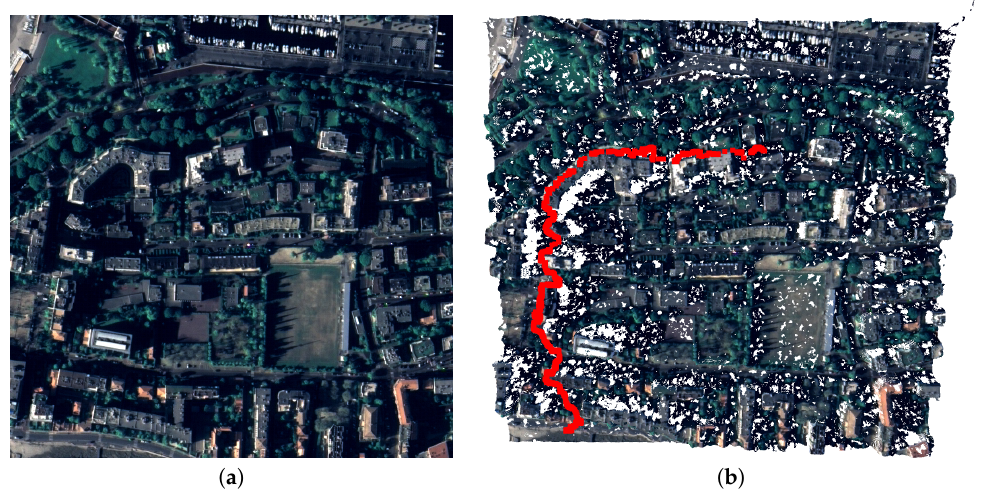
Figure 9. Estimation of a shortest path on raw point clouds of a 3D city. The point cloud has been estimated from satellite images using [42]. From left to right: ( a ) one of the satellite images used to estimate the 3D point cloud; ( b ) 3D point cloud of a city, with the shortest path depicted in red.